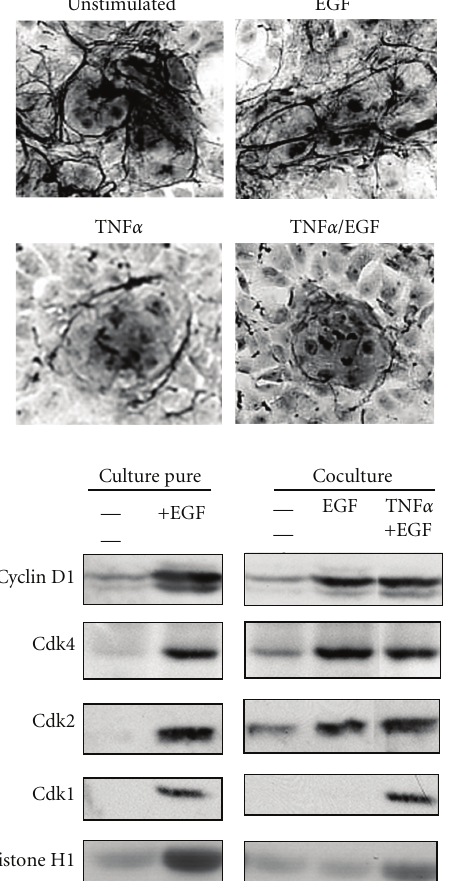
Figure 7: Upper left panel: detection of the extracellular matrix using the reticulin staining in unstimulated and EGF, TNF α or TNF α + EGF stimulated rat hepatocytes. Upper right panel: detection of BrdU positive hepatocytes in cocultured hepatocytes 3 days after stimulation with EGF, TNF α , HGF or combination of TNF α and EGF or HGF. Basal condition: unstimulated cells. Light blue: without fetal calf serum, dark blue: with fetal calf serum. Lower panel: expression of Cdks and cyclins in cultured rat hepatocytes. Cyclin D1, Cdk4, Cdk2, and Cdk1 were analyzed by western blotting. In addition, kinase activities of Cdk1 and Cdk2 were measured using histone H1 as a